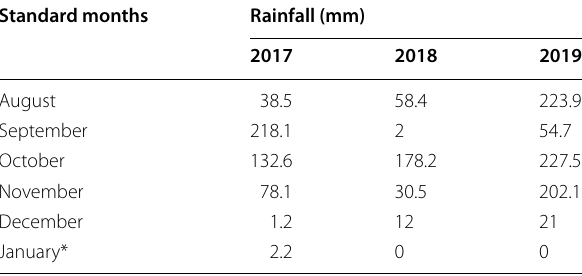
Table 1 Monthly Rainfall (mm) of experimental years